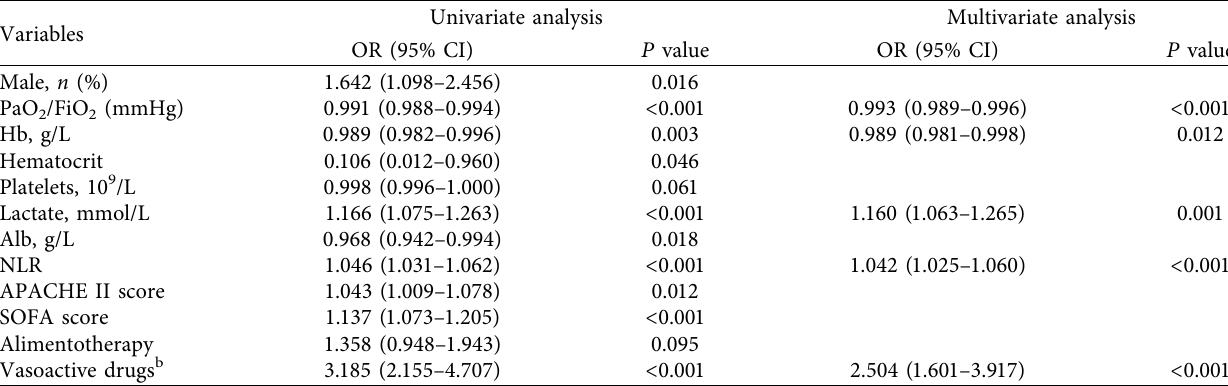
Table 3: Influence factors for requirement of IMV in ARDS patients by univariate and multivariate logistic regression analysis. Variables